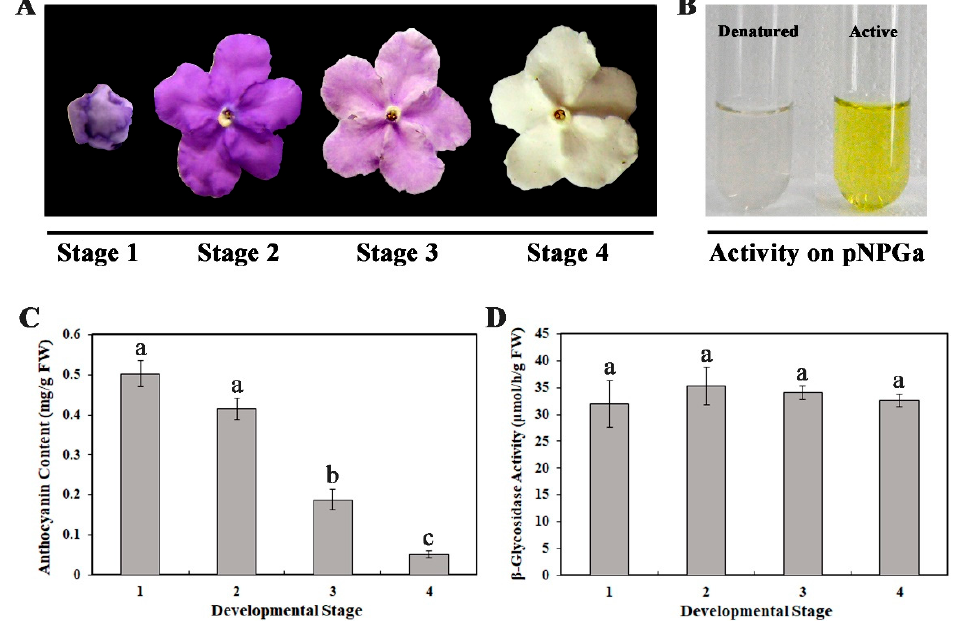
Figure 1. Anthocyanin degradation and β -glycosidase activity during flower development of Brunfelsia calycina . ( A ) The images of the flowers at different developmental stages. Stage 1 to 4 indicates purple buds, dark purple, light purple and white flower petals respectively. ( B ) β -glycosidase activity in the crude enzyme extract from B. calycina . pNPGa (p-Nitrophenyl β -D-galactopyranoside) turned yellow due to the β -glycosidase activity, with the boiled extract (denatured) as a reference. ( C ) Change in anthocyanin contents during flower development. ( D ) β -glycosidase activity during flower development. The values presented in C and D are means of three measurements from three individual extractions. Error bars indicate the standard error of mean (SEM) of the values. Different letters denote significant differences in the values according to unpaired t test ( p < 0.05), while same letters denote non-significant differences in the